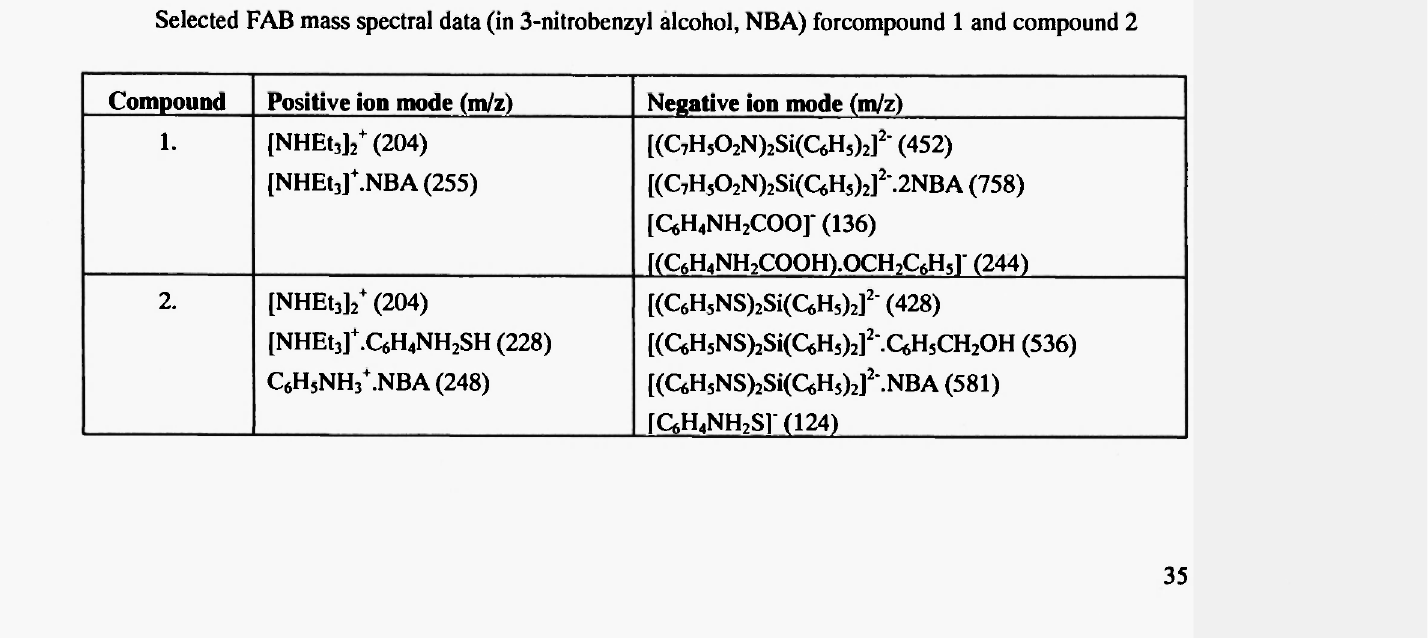
Selected FAB mass spectral data (in 3-nitrobenzyl alcohol, NBA) forcompound 1 and compound 2